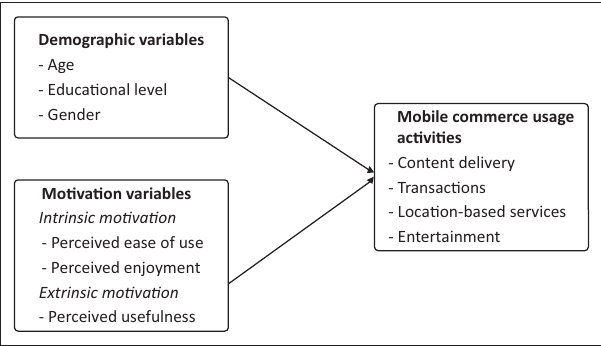
FIGURE 1: Research